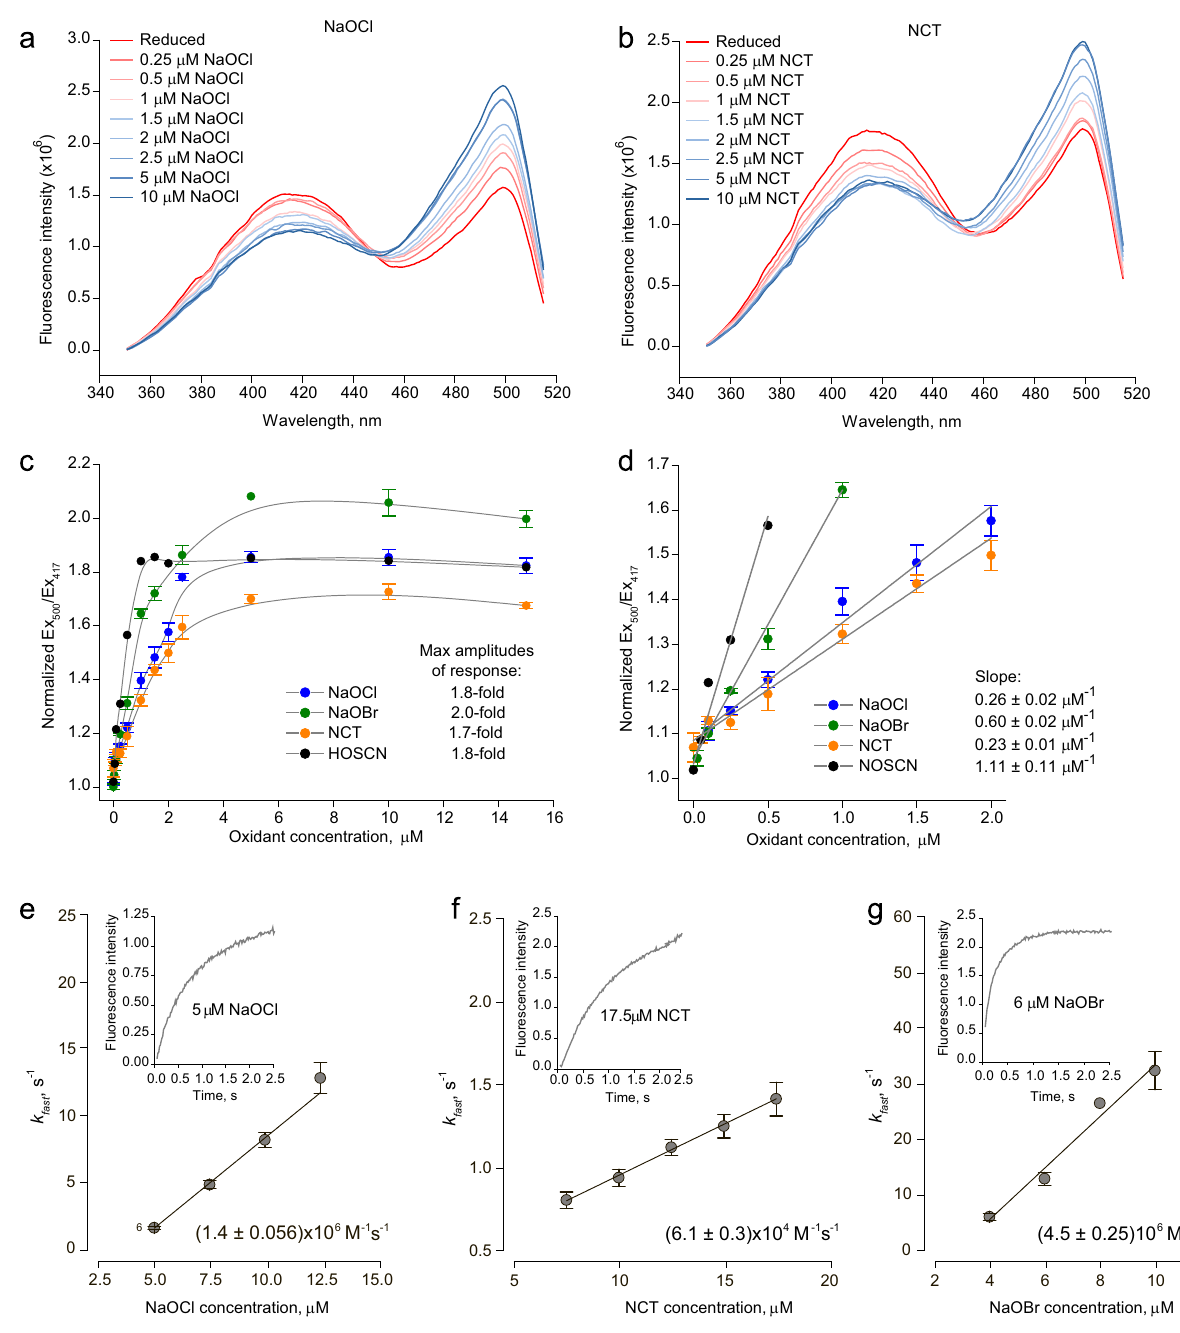
Fig. 3 Hypocrates sensitivity and reaction rates. Changes in the fl uorescence excitation spectra of Hypocrates (0.5 µ M) obtained by additions of a NaOCl or b N -chlorotaurine (NCT) aliquots. c Titration curves of Hypocrates (0.5 µ M) in sodium phosphate buffer obtained by additions of NaOCl, NaOBr, HOSCN, or NCT aliquots. The data are presented as a mean ± SEM (for n > 2), n ≥ 2. The maximum amplitudes of response are 2.0-, 1.8-, 1.8- and 1.7-fold for NaOBr, HOSCN, NaOCl, and NCT, respectively. In the presence of NaOBr, NaOCl, and NCT, the probe is saturated at ~5 µ M, and for HOSCN at ~1 µ M. d The same data as in c , Hypocrates sensitivity towards NaOCl, NaOBr, NCT, and HOSCN is shown. The data are presented as a mean ± SEM (for n > 2), n ≥ 2. e – g Hypocrates reaction rates. Changes in cpYFP fl uorescence at > 515 nm cut-off ( λ = 485 nm) were measured as a function of time (insert). The ex curves were fi tted to a double exponential to obtain the observed rate constants ( k obs/fast ), which were plotted as a function of different e NaOCl, f NCT, or g NaOBr concentrations. The second-order rate constants for NaOCl (1.4 ± 0.056) × 10 6 M − 1 s − 1 , NCT (6.1 ± 0.3) × 10 4 M − 1 s − 1 , and NaOBr (4.5 ± 0.25) × 10 6 M − 1 s − 1 were determined from the slope of the straight line [ k fast = k on ⋅ [oxidant] + k off ]. The data are presented as a mean ± SD (for n > 2), n ≥ 2. Source data are provided as a Source Data fi